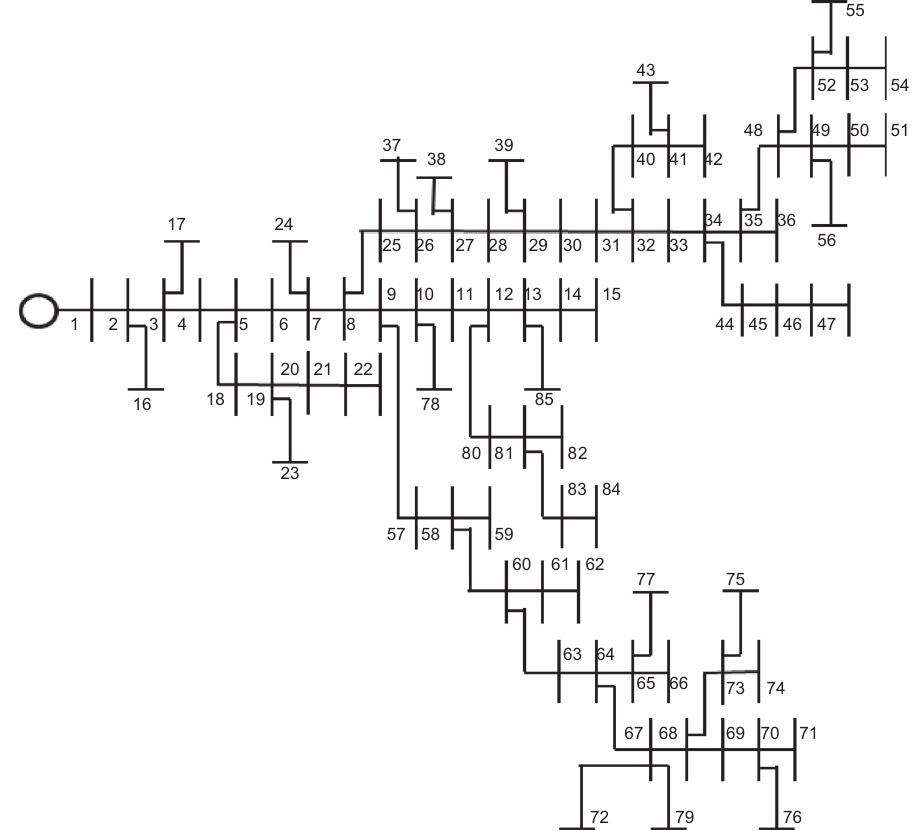
Figure 9 IEEE-85 bus radial distribution test system. Figure 3. General interconnection among nodes in the IEEE 85-node test feeder. Table 2. IEEE 85-node test feeder